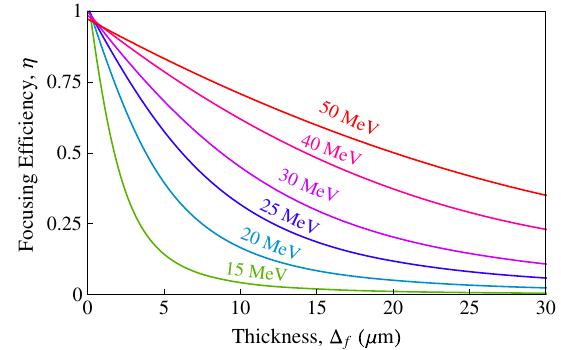
FIG. 6. Proton focusing efficiency η as a function of foil thickness Δ is computed for specified initial kinetic energies f E . Green, cyan, blue, purple, pink, red colors represent initial b ¼ 15 , 20, 25, 30, 40, and 50 kinetic energies E b